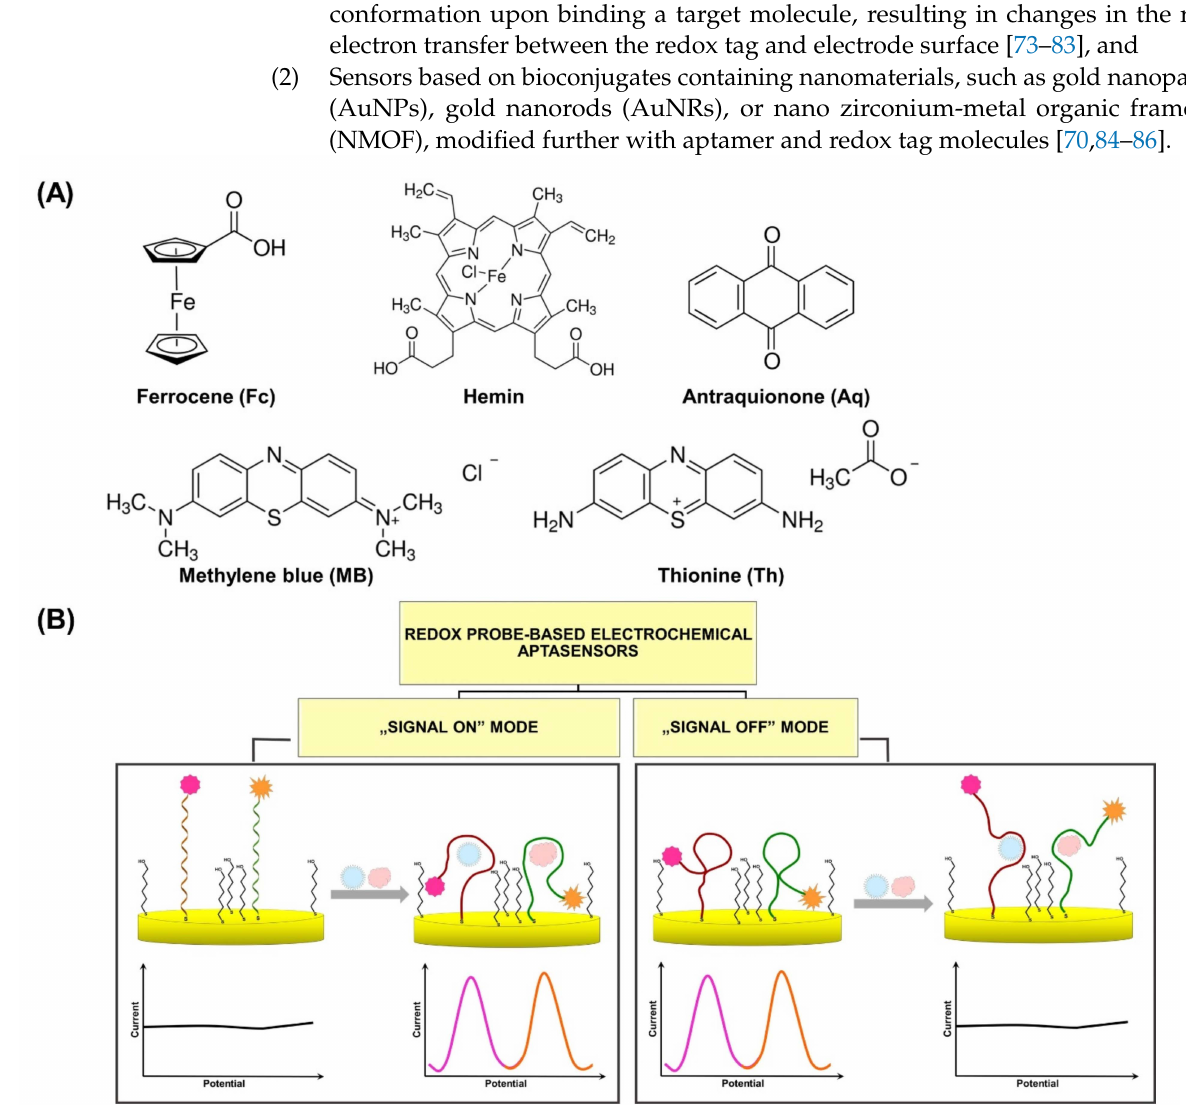
Structure-switching sensors [72], in which the redox-tag labelled aptamer alters the conformation upon binding a target molecule, resulting in changes in the rate of electron transfer between the redox tag and electrode surface [73–83], and Sensors based on bioconjugates containing nanomaterials, such as gold nanoparticles (AuNPs), gold nanorods (AuNRs), or nano zirconium-metal organic